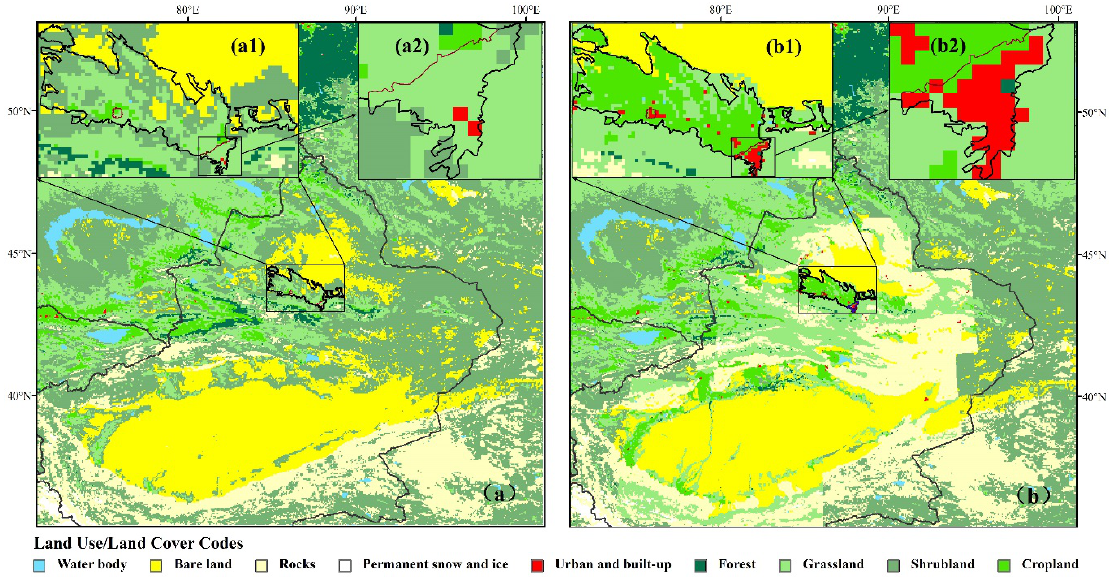
Figure 2. The default land cover data from ECOCLIMAP ( a ) and the updated land cover data using the XIEG land cover database ( b ). The zoom-in figures ( a 1, b 1), ( a 2, b 2) show the land cover in oasis and Urumqi, respectively.